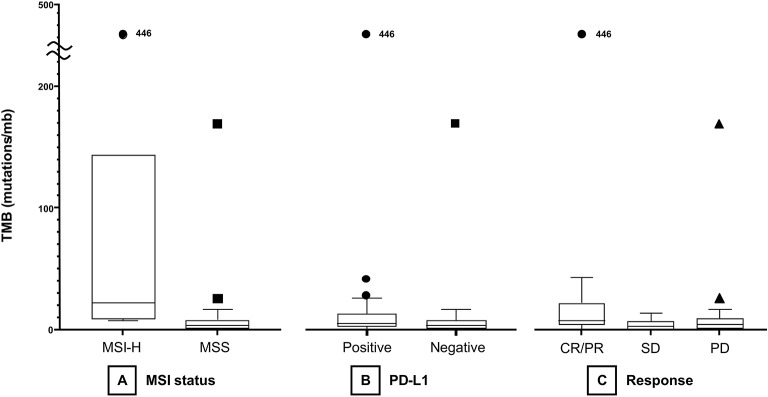
Boxplots of TMB according to MSI status (A), PD-L1 positivity (B), and treatment response (C). TMB, tumor mutational burden; MSI, microsatellite instability; MSS, microsatellite-stable; PD-L1, programmed death-ligand 1; CR, complete response; PR, partial response; SD, stable disease; PD, progressive disease.